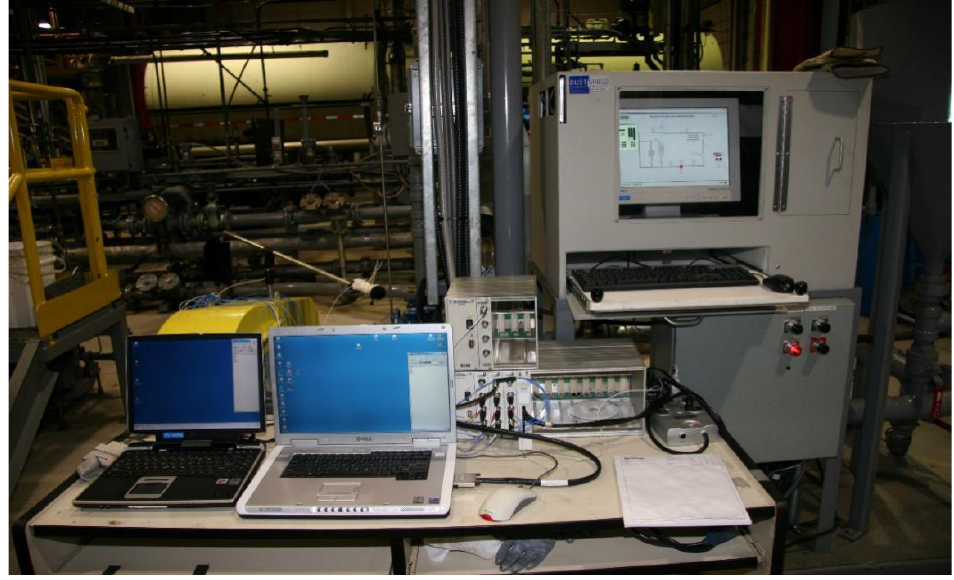
Figure 5. Data acquisition system.